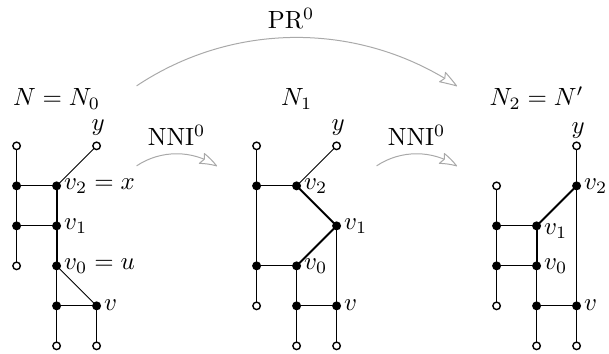
Figure 6: How to mimic the PR 0 that prunes the edge { u, v } at u and regrafts to { x, y } with NNI 0 operations that move u of { u, v } along the path P = ( u = v